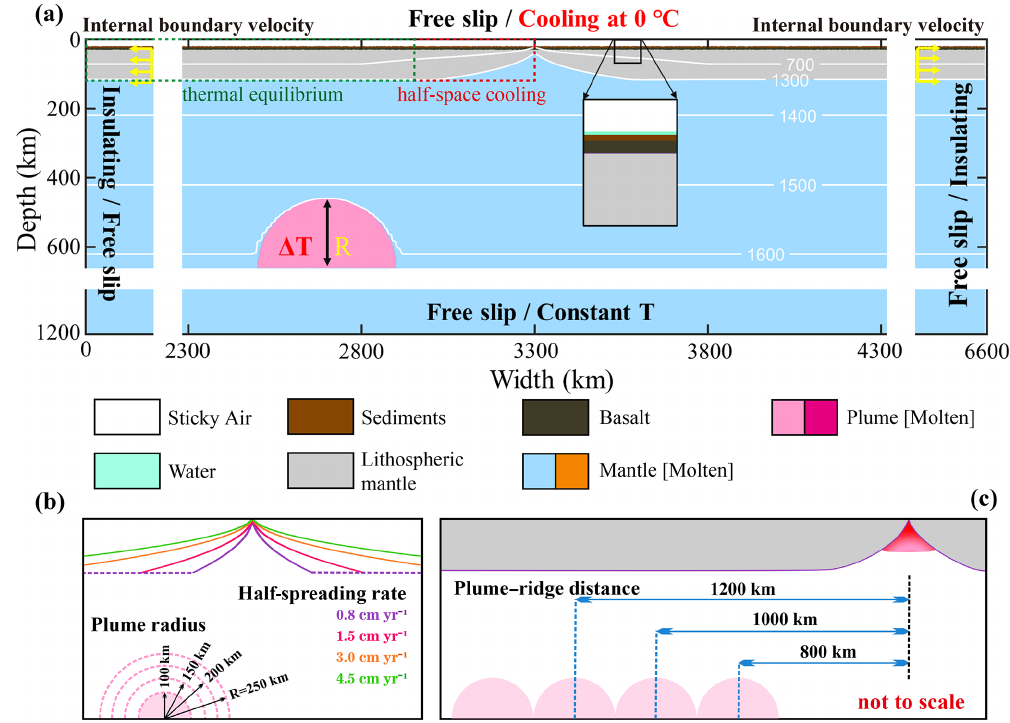
Figure 2. Model setup. (a) Initial composition and boundary conditions. The oceanic plate consists of half-space cooling part and the thermal equilibrium part. A 50Myr old mid-ocean ridge is set in the middle of the model based on half-space cooling-temperature structure. A thermal and chemical anormal mantle plume is located at 660km. Different colors indicate the initial rock types and corresponding newly formed molten-rock types. Yellow arrows are the half-spreading rates imposed internally in the lithosphere (i.e., from 20 to 120km in depth) to simulate ridge spreading. (b) Initial tested ridge and plume configurations. (c) Initial tested plume–ridge distances.